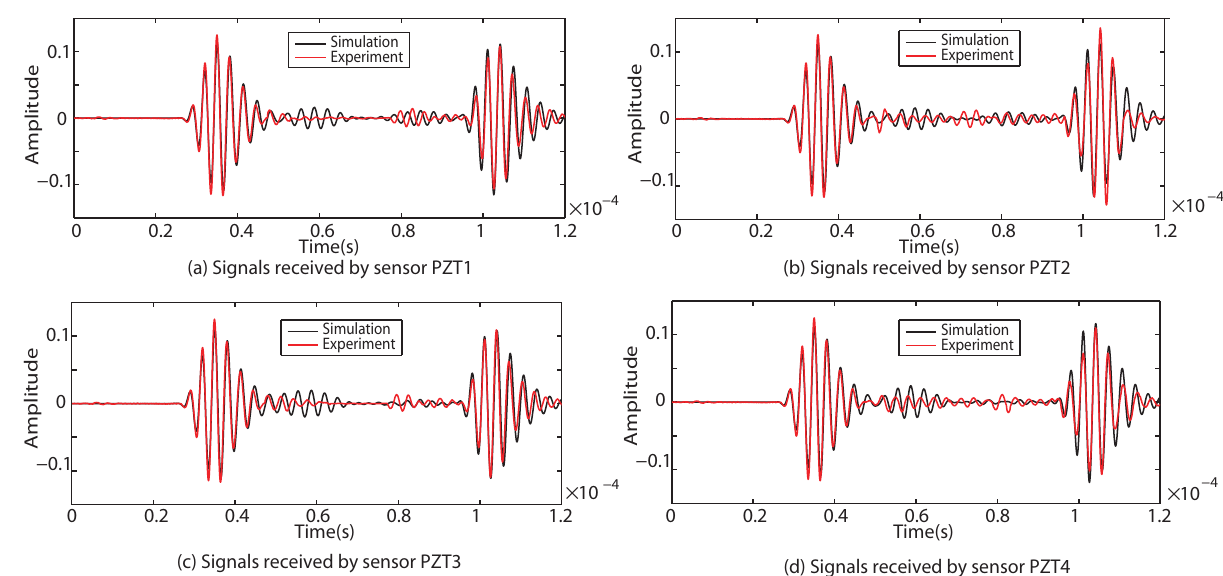
Figure 10. Comparison of experimental and simulation results under Case